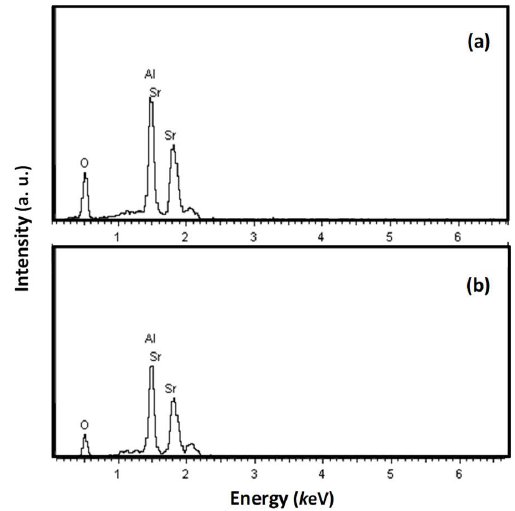
Figure 3. Energy-dispersive X-ray (EDX) spectra of SAOs synthesized by ( a ) hydrothermal reaction and ( b ) sol–gel method.